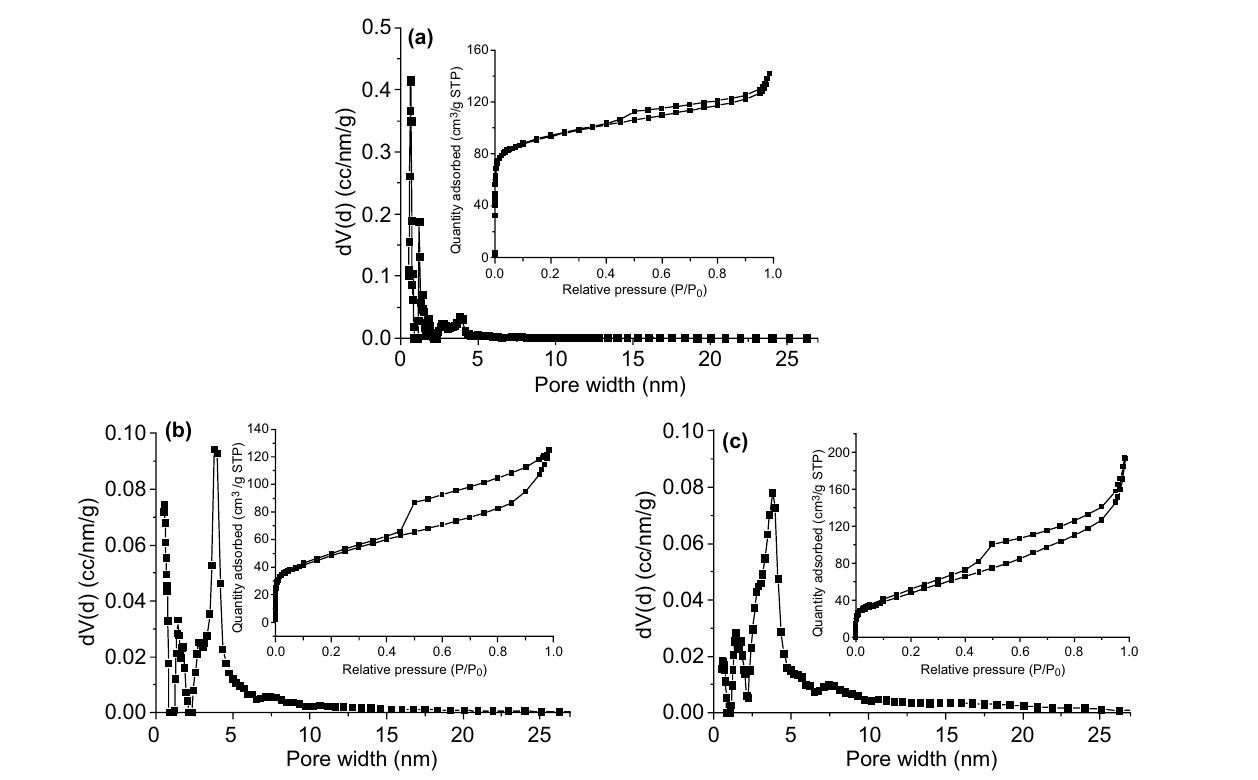
Fig. 6 Pore size distribution plots and N 2 adsorption–desorption isotherms of a Co/NC, b Fe–Co/NC, and c